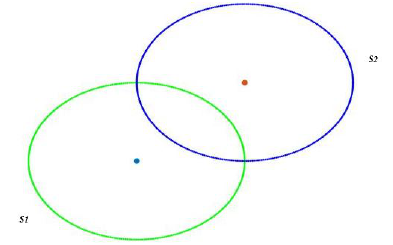
Figure 2. Two unconnected